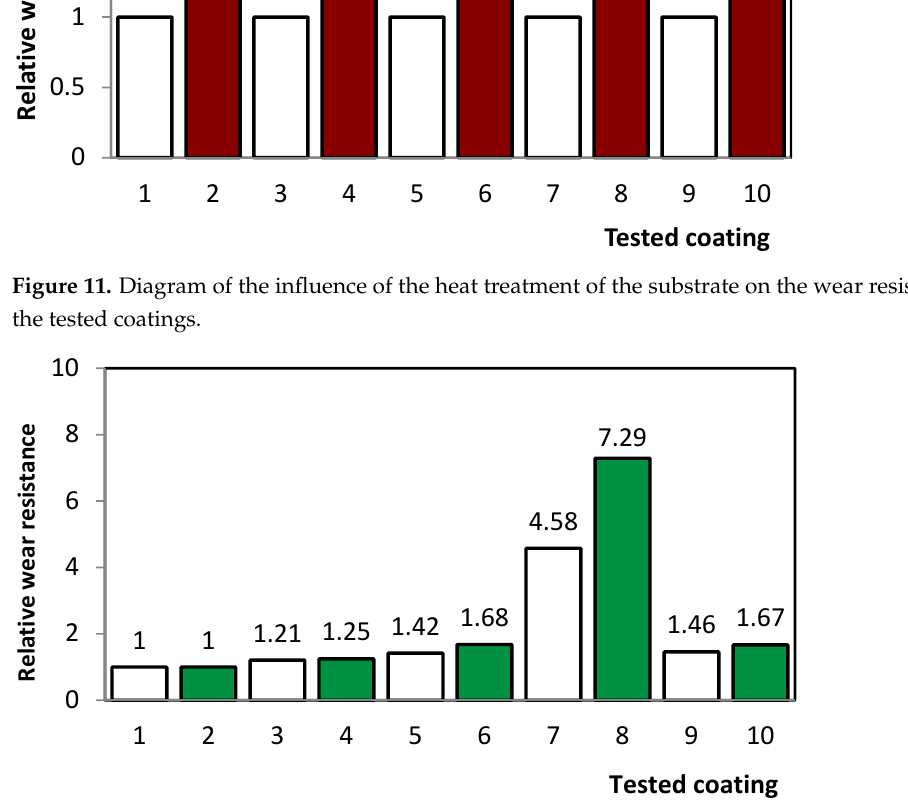
Figure 12. Diagram of the influence of Cr concentration on the wear resistance of the tested